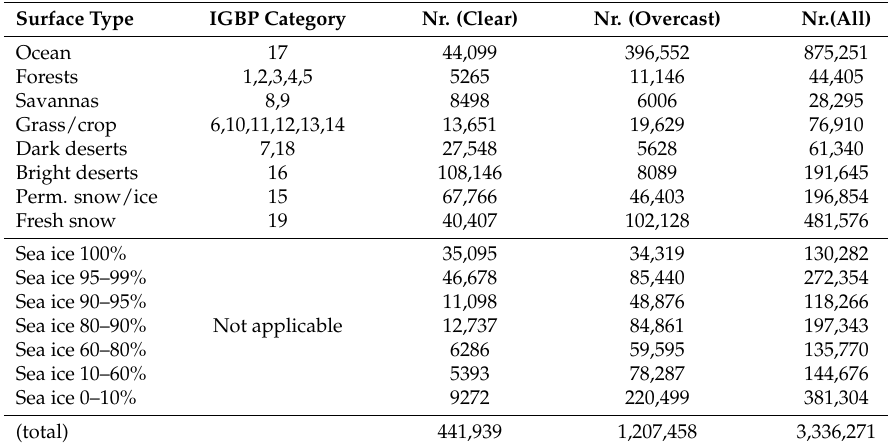
Table 2. Surface types, corresponding IGBP categories, and number of matched NTB pairs (with strict matching criteria) for clear, overcast, and all-sky conditions; Data: 2004–2005 (NOAA17+Terra), 2007–2008 (NOAA18+Aqua) and 2011–2012